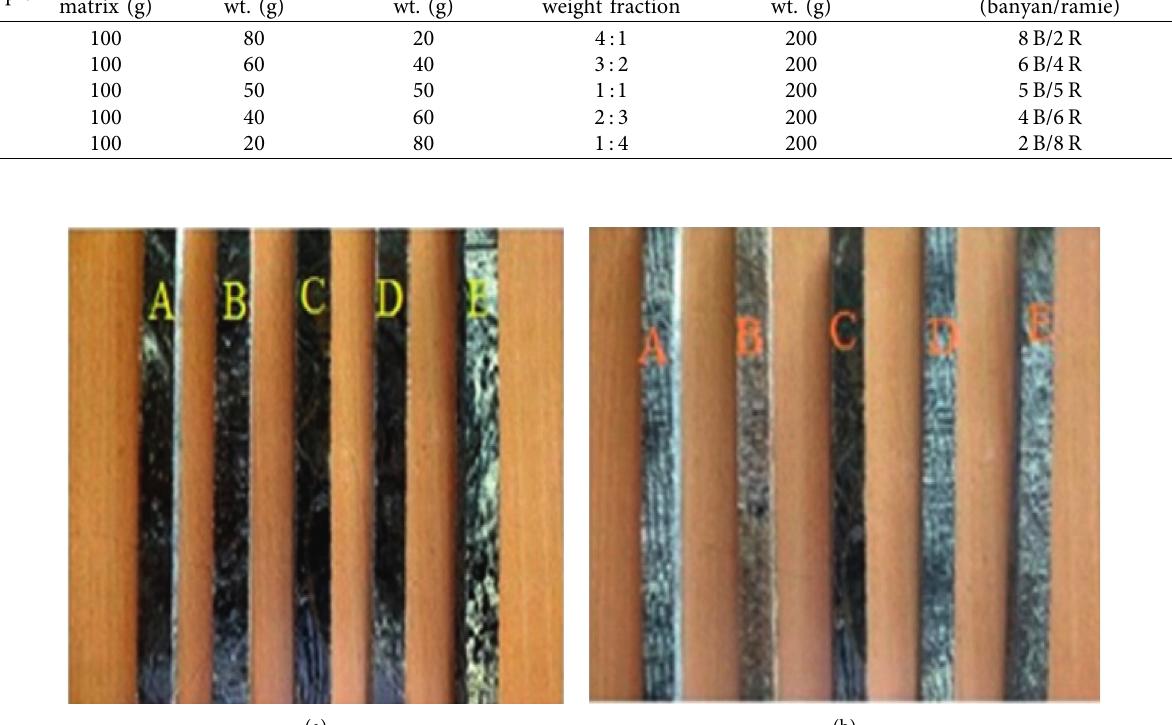
Figure 1: Tested samples for the flexural test of hybrid composite. (a) Silane-treated samples. (b) Untreated